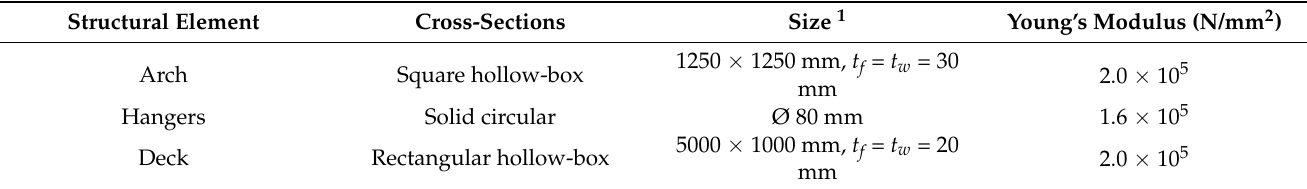
Table 1. Definition of reference bridges.